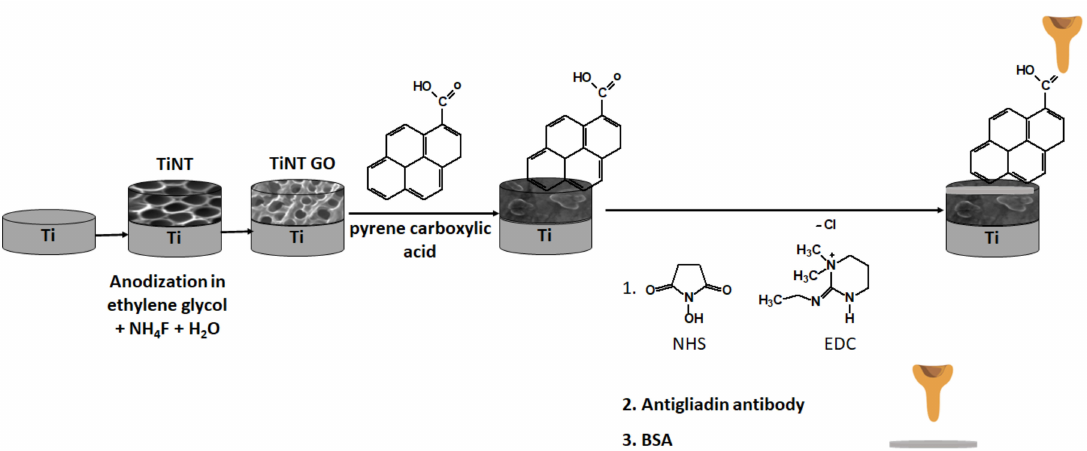
Figure 1. Nanostructured titanium modified with graphene oxide and antibody.